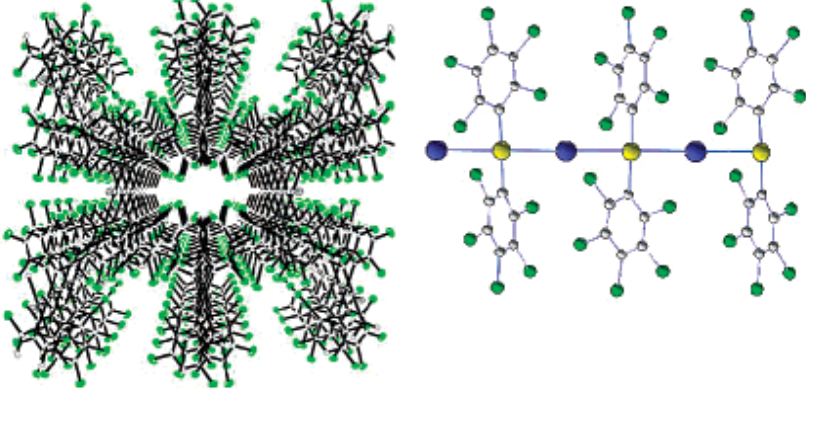
Figure 6. Crystal structure of {Tl[Au(C Inset: the polymeric molecular structure of {Tl[Au(C from